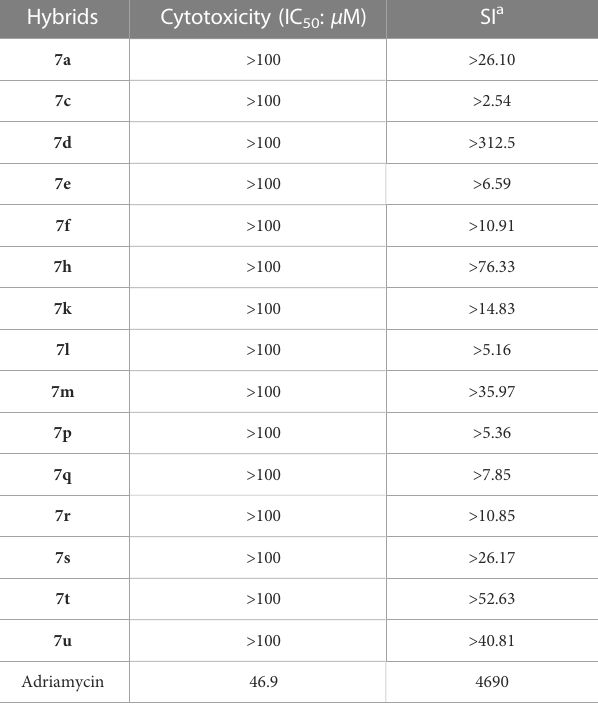
hydrochlorides (2.0 mmol) in a mixture of THF (20 mL) and H 2 O (10 mL), sodium carbonate (Na 2 CO 3 , 5.0 mmol) was added. The mixture was stirred at 40°C for 12 h, and then cooled to room temperature. The mixture was extracted with dichloromethane (DCM, 30 mL × 3). The combined organic layers were washed with H 2 O (40 mL) and brine (40 mL) in sequence, dried over anhydrous sodium sulfate (Na 2 SO 4 ), fi ltered and concentrated under reduced pressure. The residue was puri fi ed by silica gel chromatography eluted with PE to PE: EA = 1: 1 to give the desired ART-isatin hybrids 7a-u.